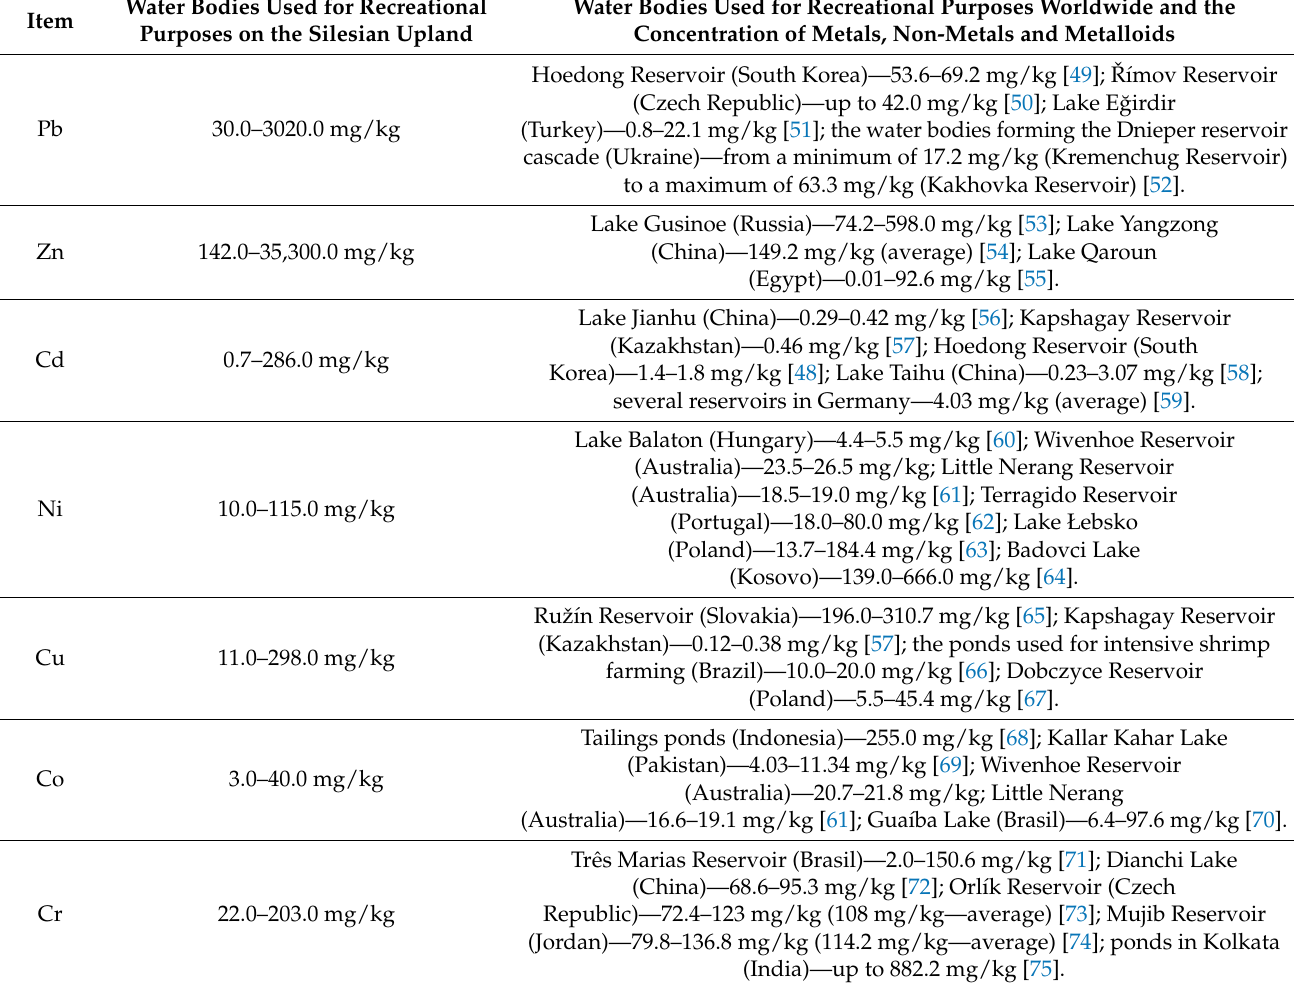
Table 6. Concentrations of metals, non-metals and metalloids in the bottom sediments of selected water bodies used for recreational purposes